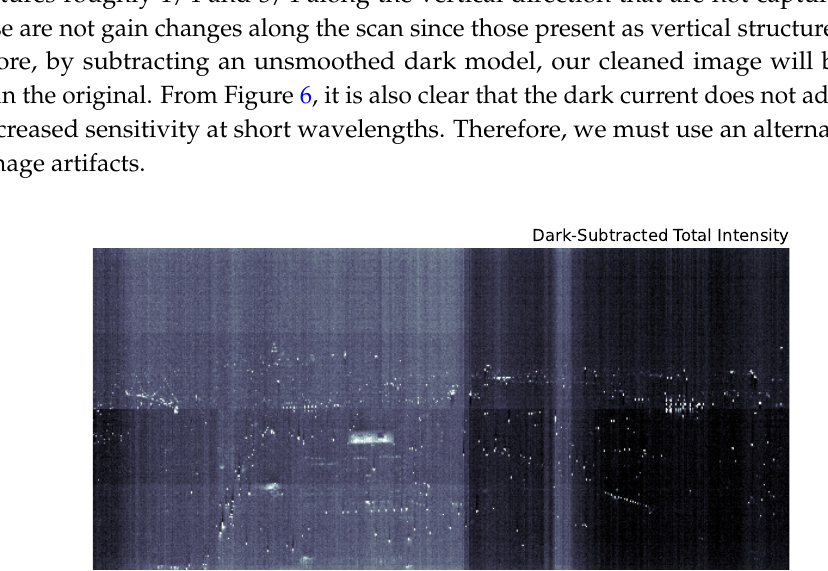
Figure 5. The same as Figure 3 except a dark scan has been subtracted. Although the chip offset is mostly removed, there are clearly additional chip features roughly 1/4 and 3/4 along the vertical direction of the CCD (the gain artifacts are obviously not removed by the dark scan, as well).